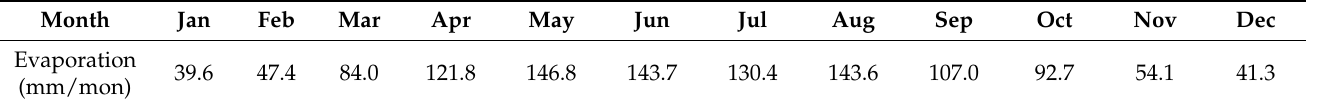
Table 4. Monthly